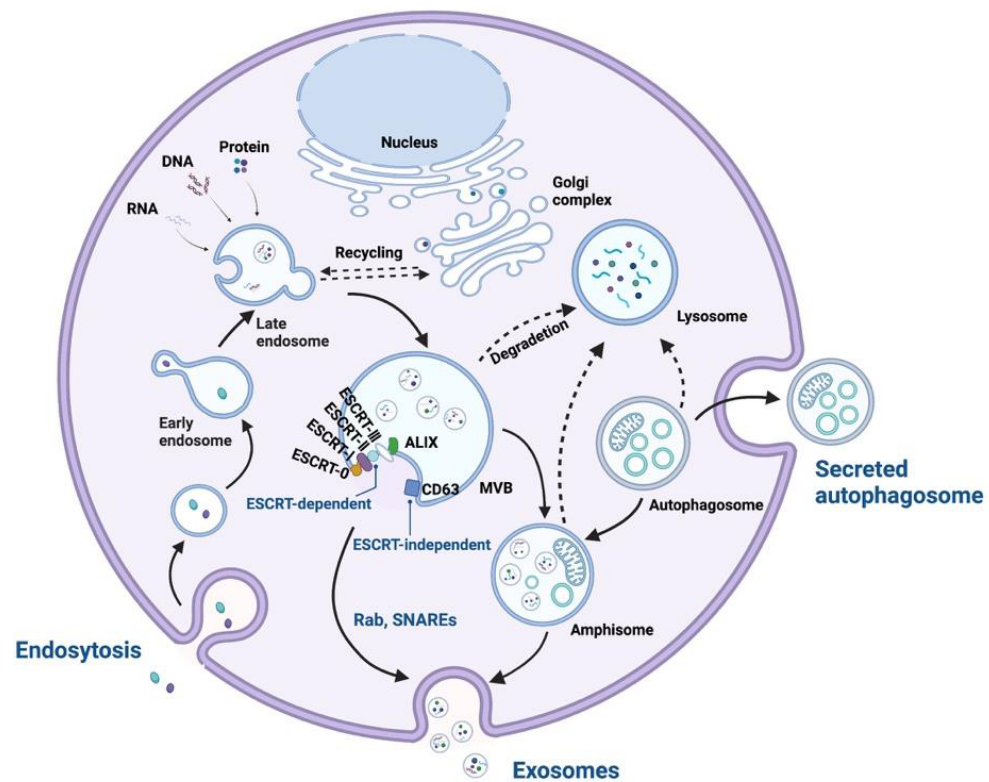
Figure 2. The overview of exosome biogenesis and related proteins. First, the cell plasma membrane 96 buds to form an early endosome. Then, the early endosomes give rise to late endosomes. Usually, 97 multiple late endosomes are packaged into MVBs. MVBs are the center of exosome biogenesis and 98 can communicate with organelles, such as Golgi and endoplasmic reticulum to exchange cargo. In 99 ESCRT-dependent pathway, TSG101, VPS4, and ALIX participate in forming ESCRT-complex and 100 releasing exosomes from MVBs. In ESCRT-independent pathway, CD63 can help MVB release exo- 101 somes. Other proteins, including Rab and SNAREs, are responsible for membrane fusion and re- 102 leasing exosomes outside cells.